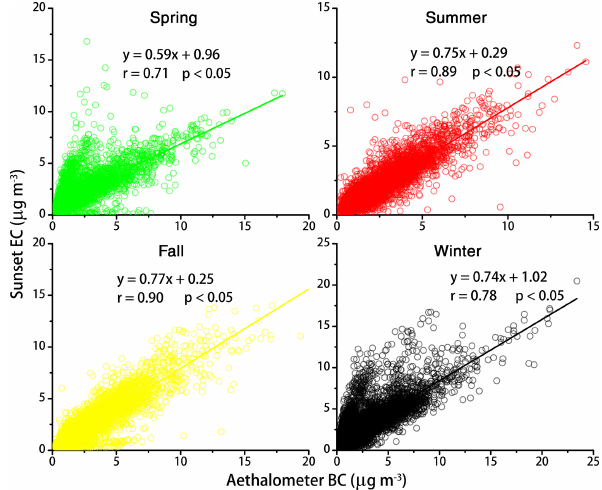
Figure 2. Comparison between collocated Aethalometer BC and Sunset Laboratory EC concentrations for different